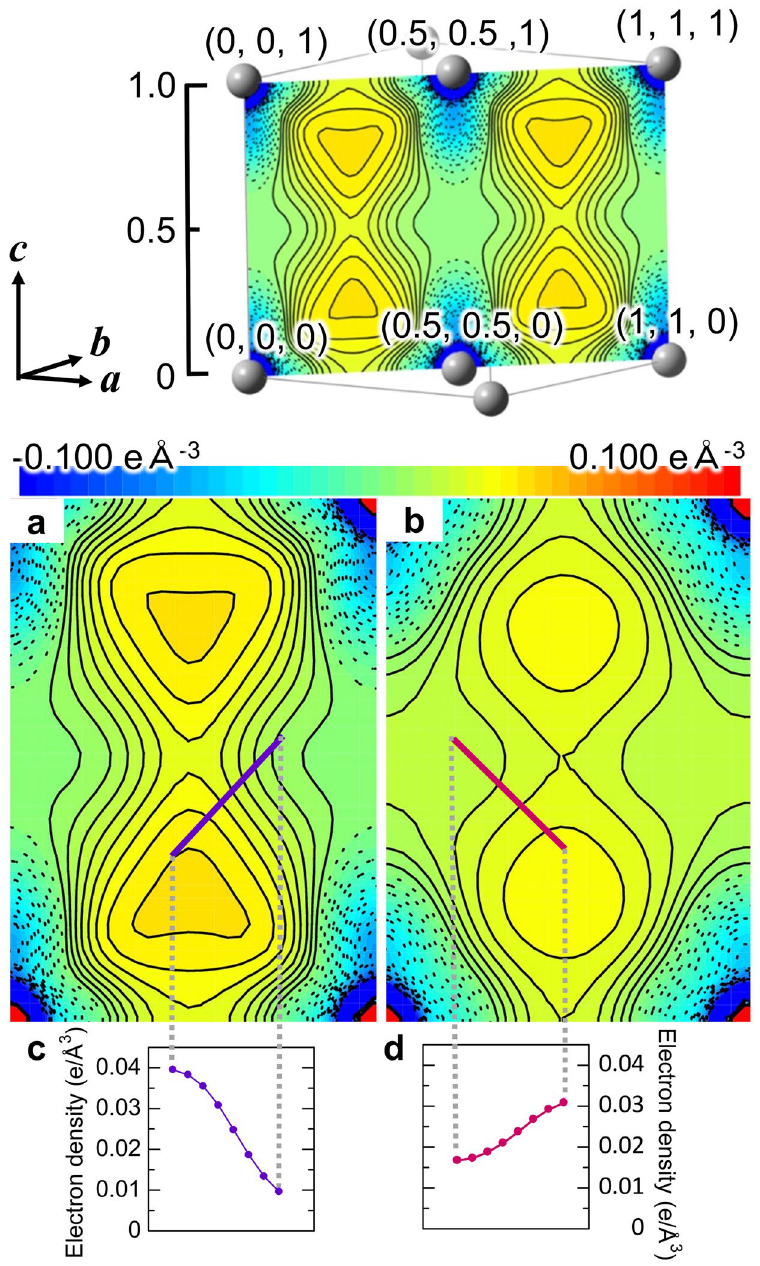
Figure 3. Static deformation density of (110) plane. The present experimental ( a ) and theoretical deformation density ( b ). The drawing (110) plane is shown in the upper inset. Aluminum atoms are at four corners. The contour interval is 0.005 eÅ − 3 in − 0.1–0.1 eÅ − 3 region. Solid and dotted lines show positive and negative contours, respectively. ( c , d ) Electron density values along purple and red solid line in ( a ) and ( b ),